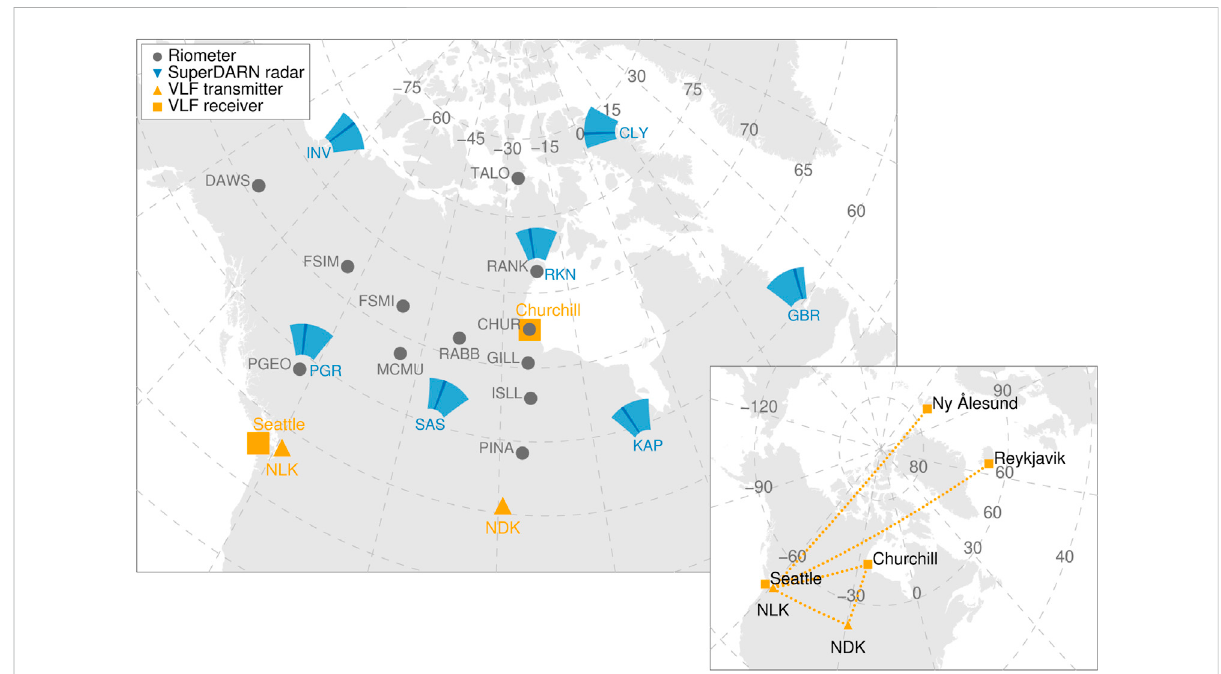
FIGURE 1 Locations and fi elds of view of the riometers, SuperDARN radars, and VLF transmitters and receivers used in this study. For the SuperDARN radars, only the near-range fi eld of view is shown, and the shading indicates the beam direction that was used (see text for details). The propagation paths between selected VLF transmitter – receiver pairs are shown in the